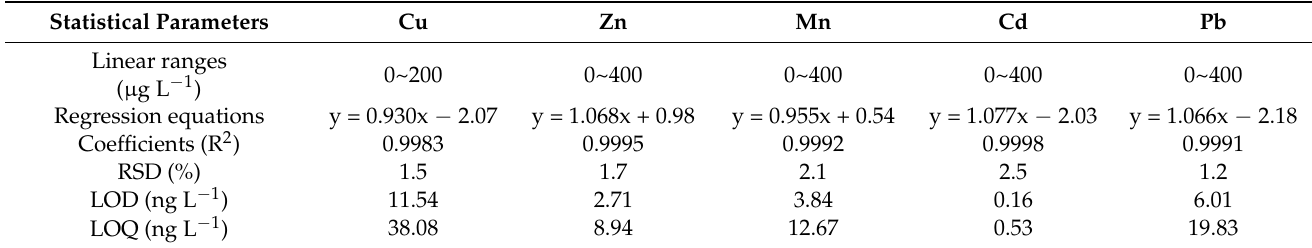
Table 1. Analytical parameters of the proposed method.